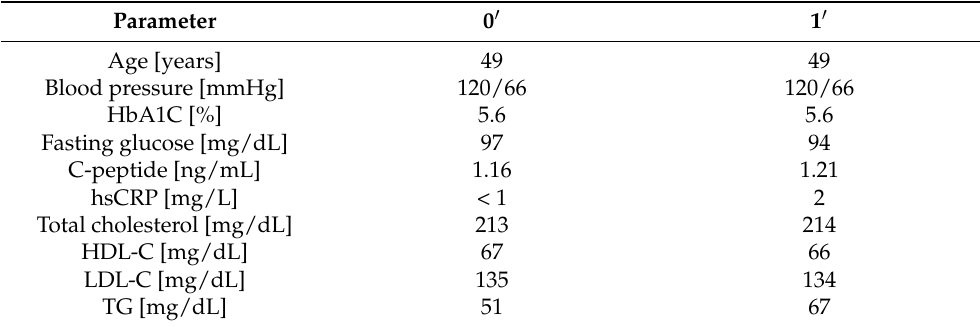
Table 2. Biochemical parameters before and after the MLD therapy in a patient with normal body